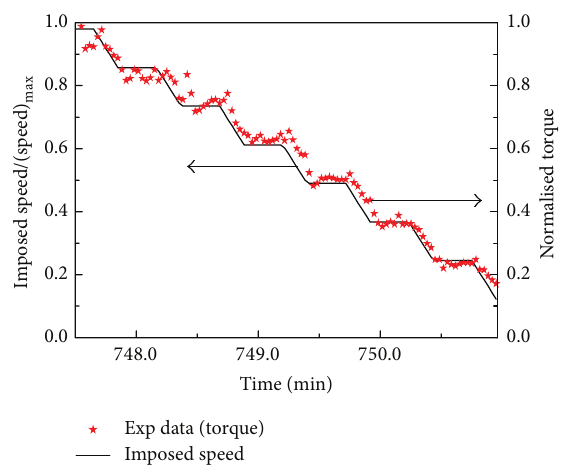
Figure 5: Evolution of the imposed speed of the cylinder and of the measured torques according to the